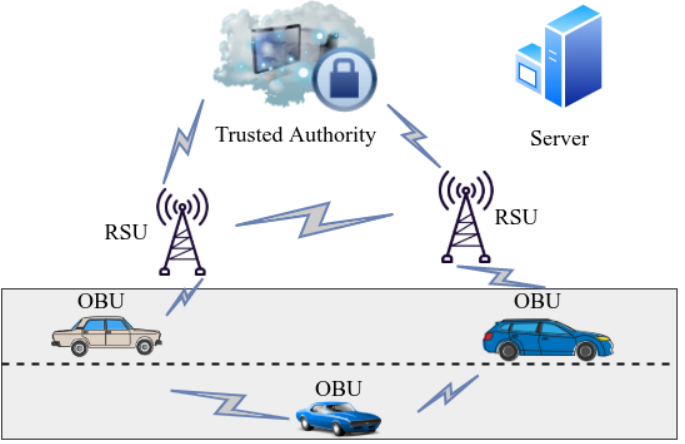
Figure 1. VANET Generic